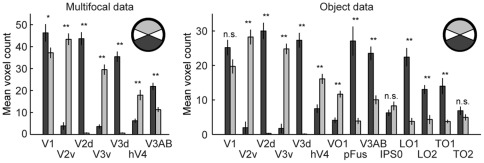
Asymmetries in visual field representations.The mean numbers of voxels that represented the lower (dark gray bars) and the upper (light gray bars) visual fields in different visual areas were averaged across the 15 subjects. The error bars indicate the SEMs across the subjects. **p<0.005, Wilcoxon Signed Rank-test; n.s., not significant (p>0.05, Wilcoxon Signed Rank-test).